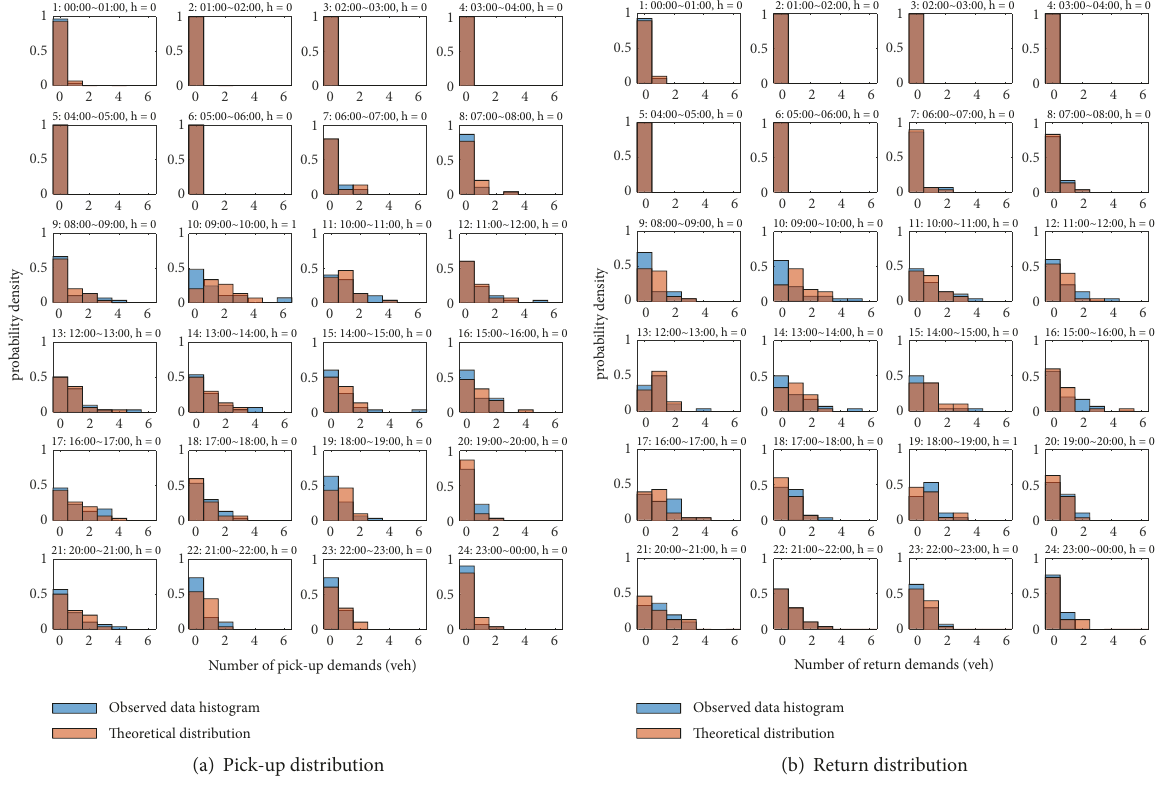
Figure 2: Observed histogram and theoretical distribution of pick-up and return